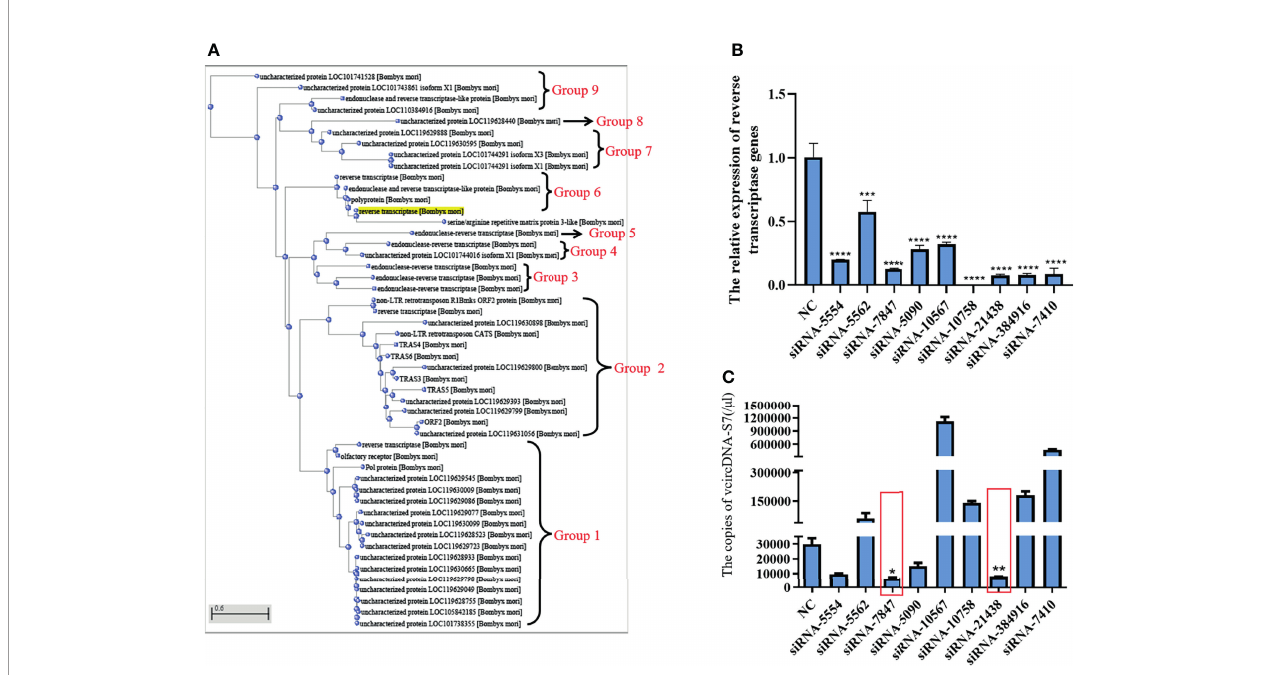
FIGURE 3 | The source of reverse transcriptase activity involved in vcDNA-S7 formation. (A) Cluster analysis of genes encoding reverse transcriptase in silkworm. reverse transcriptases genes in the silkworm were divided into 9 groups. (B) Silencing ef fi ciency of siRNAs on 9 groups of genes encoding reverse transcriptase. siRNA. 1×10 6 BmN cells were transfected with siRNAs for 48 h, and were infected with BmCPV for another 48 h. Total RNA was extracted and the expression level of reverse transcriptase genes relative to housekeeper gene TIF-4A was detected by real-time PCR. (C) 1×10 6 BmN cells were transfected with siRNAs for 48 h, and were infected with BmCPV for another 48 h. The copies of vcDNA-S7 were determined by real-time PCR. (n=3, *, P <0.05; ** P <0.01; *** P <0.001; **** P